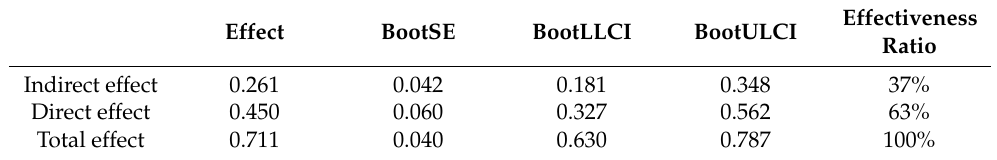
Table 5. Decomposition of total utility, direct effects, and mediating